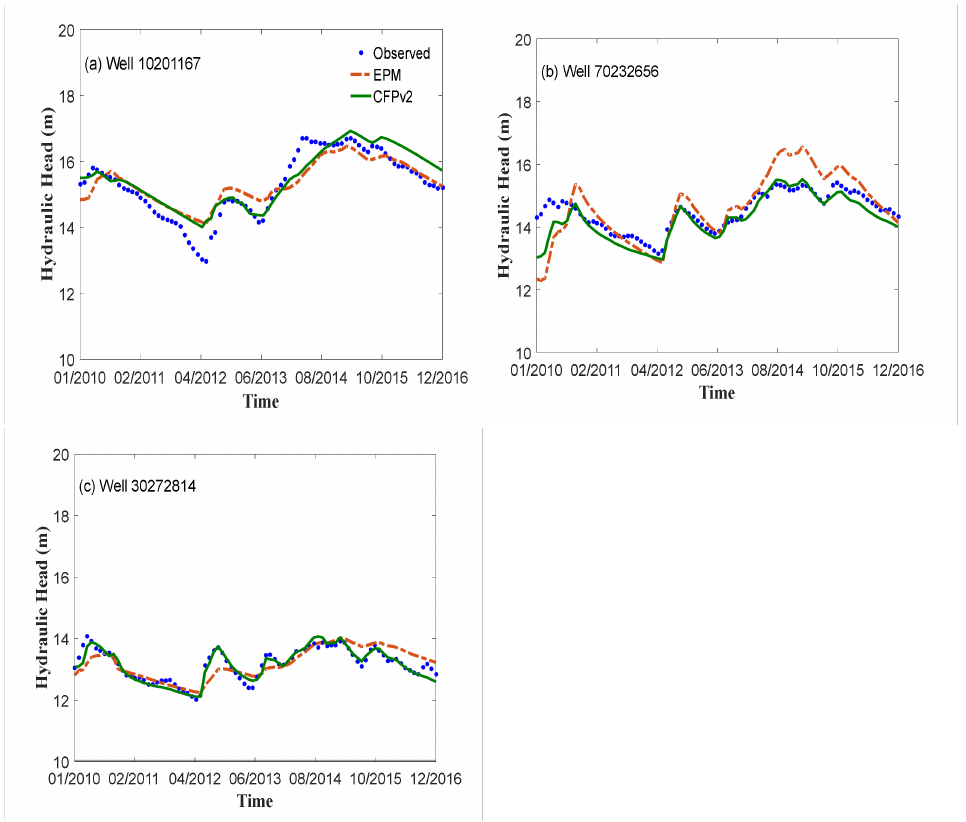
Figure 7. The observed and simulated potentiometric heads in ( a ) well 10201167 (located in the upper poorly-karstified region of the springshed), ( b ) well 70232656 (located approach to well-karstified region of the springshed), and ( c ) well 30272814 (located in the central conduit-adjacent region of the springshed). Well numbers and locations are shown in Figure